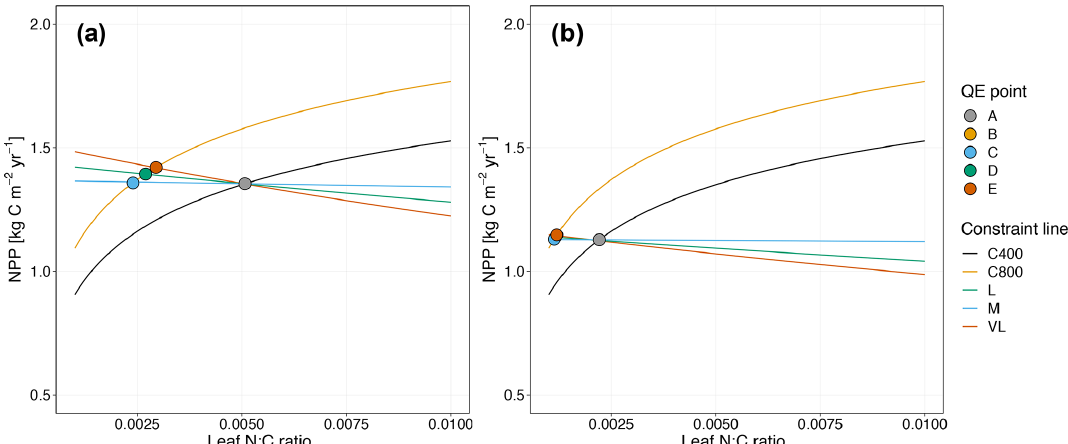
Figure 5. Graphic interpretation of the effect on CO 2 responses with models incorporating the relative demand assumption based on vari- able (a) and fixed (b) wood N:C ratio assumptions. Constraint lines C400, C800, M, L, and VL refer to photosynthetic constraints at CO 2 = 400ppm, CO 2 = 800ppm, medium-term, long-term, and very-long-term nutrient recycling constraints, respectively. Point A is the quasi-equilibrium point at CO 2 = 400ppm, point B is the instantaneous response point at elevated CO 2 , and points C, D, and E are the M-, L-, and VL-term equilibrium points at elevated CO 2 .